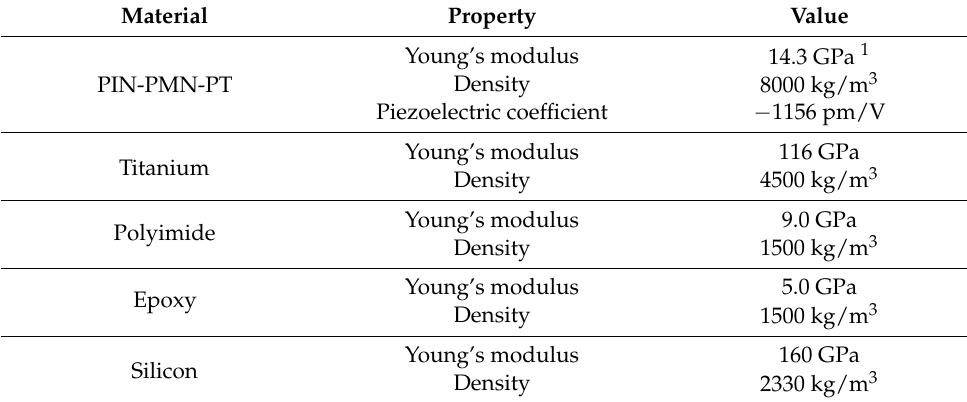
Table A1. Material properties for